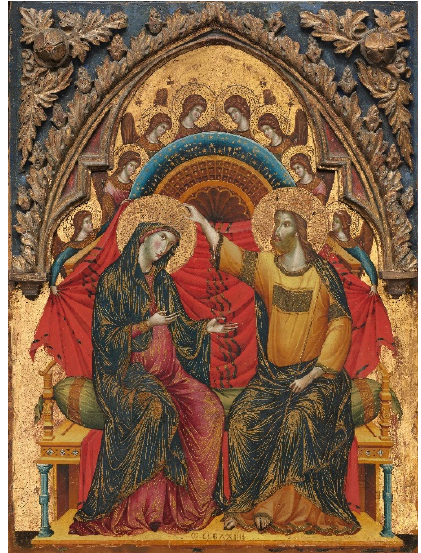
Figure 1. The Master of the Washington Coronation, The Coronation of the Virgin , c. 1333–1362. National Gallery of Art, Washington, DC.